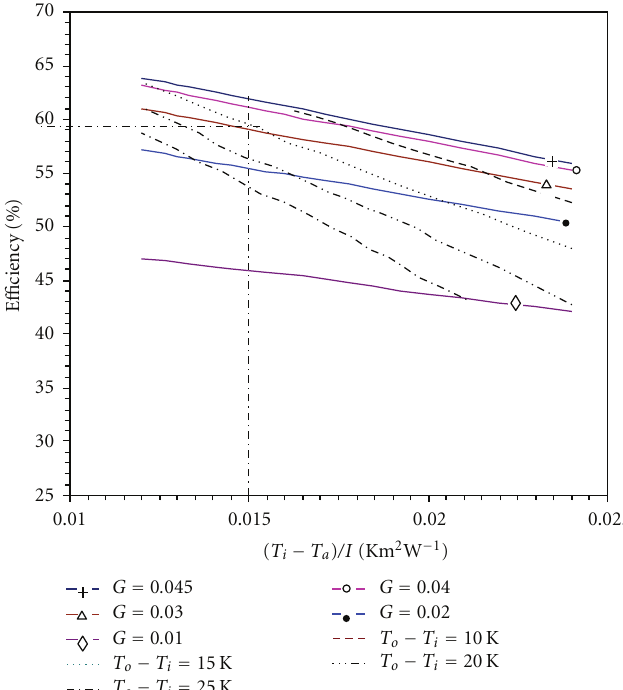
F 7: ermal efficiency of roughened solar air heater as function of temperature